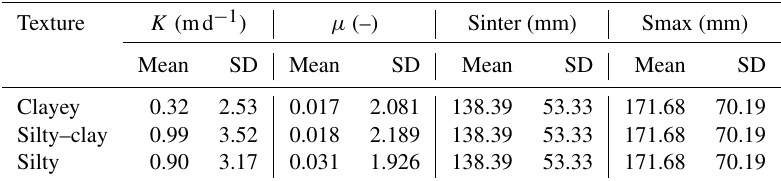
Table A1. Table of mean and standard deviation (SD) per soil texture used for the parameter distribution.